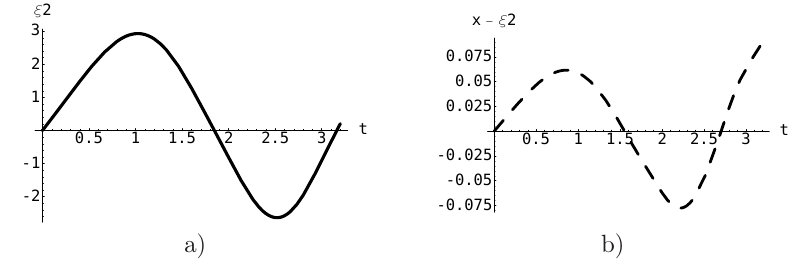
Figure 7. 2 -type solution of the problem (3.15).